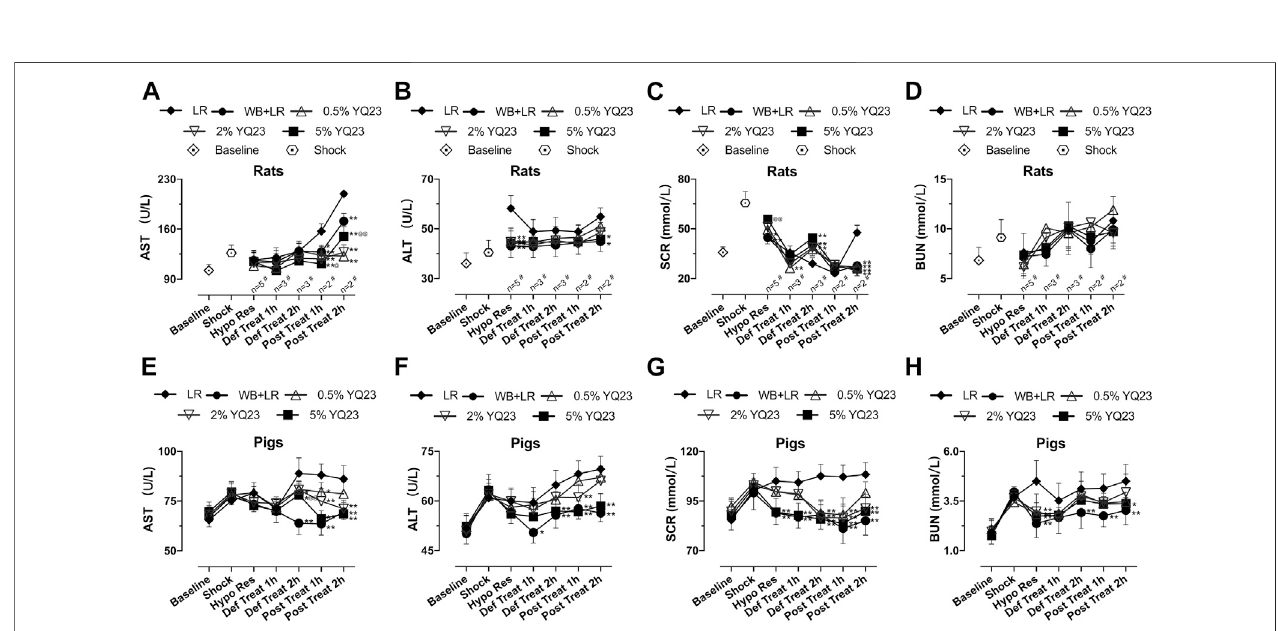
FIGURE6|YQ23reducedliverandkidneyinjuryfollowinguncontrolledhemorrhagicshockinratsandpigs.(A) ,ASTinrats; (B) ,ALTinrats; (C) ,SCRin rats; (D) ,BUNinrats; (E) ,ASTinpigs; (F) ,ALTinpigs; (G) ,SCRinpigs; (H) ,BUNinpigs( n (cid:1) 10/groupinratsexperimentunlessotherwiseannotated, n (cid:1) 6/groupinpig experiment). AST, aspartate aminotransferase; ALT, alanine aminotransferase; BUN, blood urea nitrogen; SCR, serum creatinine; LR, Lactate Ringer ’ s solution; WB, wholeblood.* p < 0.05v.s.LRatthesametimepoint,** p < 0.01v.s.LRatthesametimepoint, @ p < 0.05v.s.WB+LRatthesametimepoint, @@ p < 0.01v.s.WB + LR at the same time point, # n of LR group at the corresponding time point (sample size was decreased because of animal death).